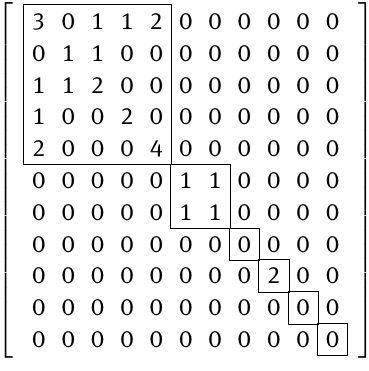
Figure 2: Block diagonal form according to common out-neighbor partition.